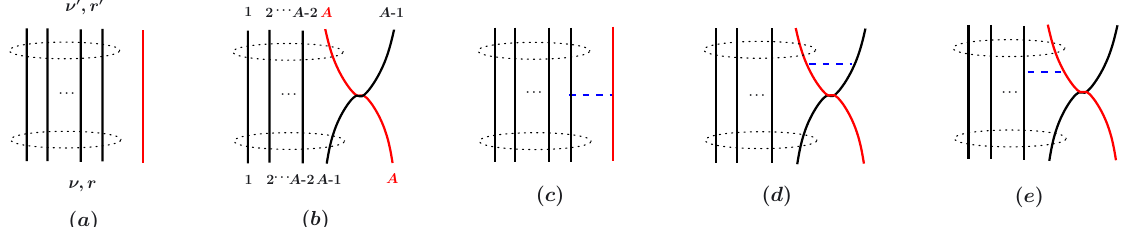
(cid:41)(cid:76)(cid:74)(cid:17) (cid:20)(cid:17) Diagrammatic representation of: ( a ) “direct” and ( b ) “exchange” components of the norm kernel; ( c and d ) “direct” and ( e ) “exchange” components of the potential kernel for the ( A − 1 , 1) cluster basis. The first group of circled lines represents the first cluster, the bound state of A − 1 nucleons. The separate line represents the second cluster, in the specific case a single nucleon. Bottom and upper part of the diagram represent initial and final states,